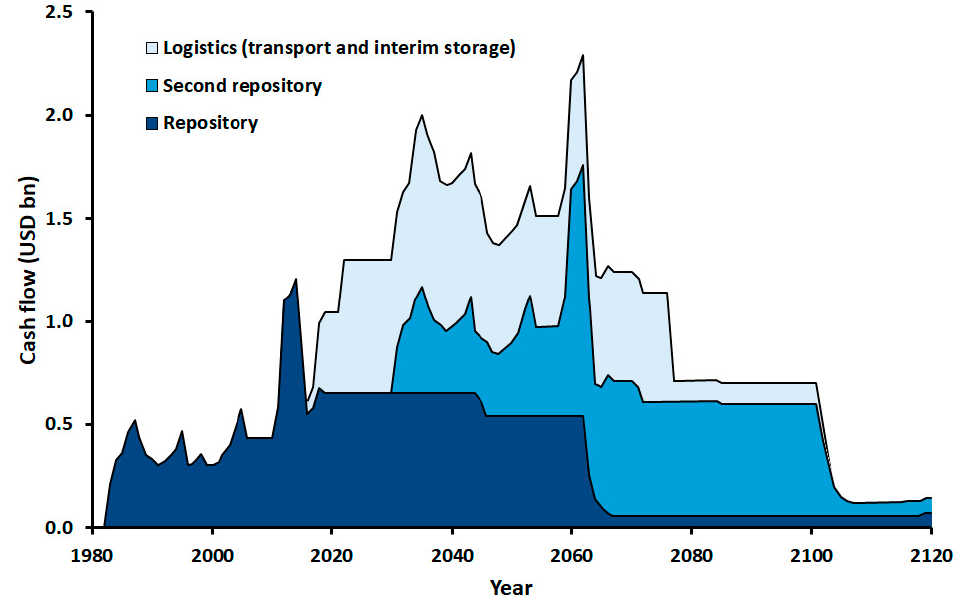
Figure 4. Cash flow profile for once-through strategy (acceptance of used fuel begins 2010–2020) [43].